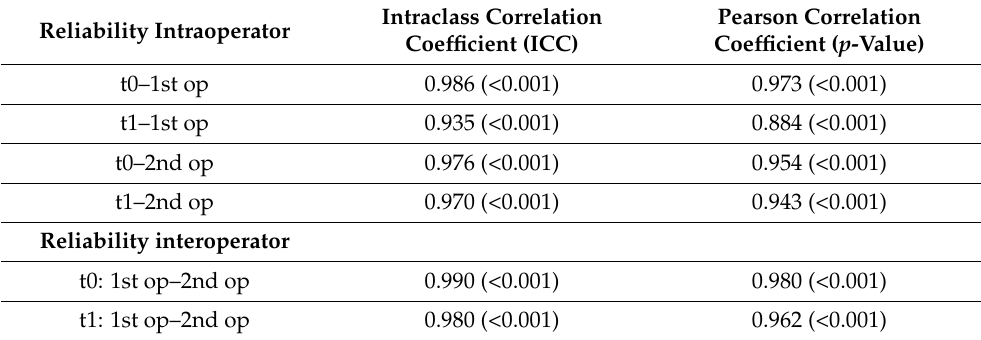
Table 2. Inter- and intraoperator reliability evaluation with ICC and